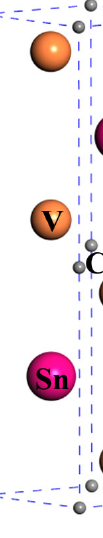
Fig. 1 Crystal structure of V 2 SnC. Table 1 Crystal structure parameters of V 2